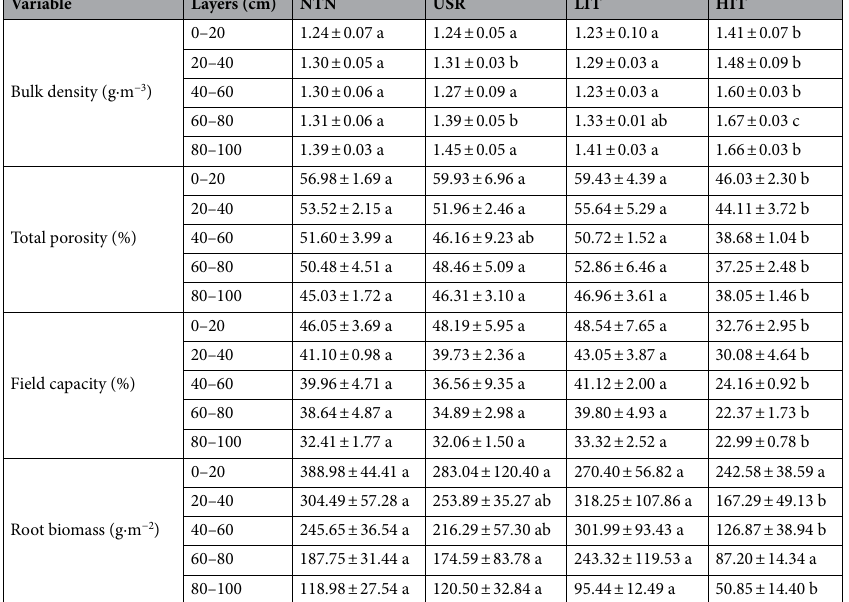
Table 4. Soil properties and root biomass in P. massoniana stands under different forest management practices. Means ± standard deviations (n = 3) are shown, and different letters shown in the same row denote significant differences between the different forest management systems at P < 0.05. NTN no thinning stand, USR understory removal stand, LIT light-intensity thinning stand, HIT heavy-intensity thinning